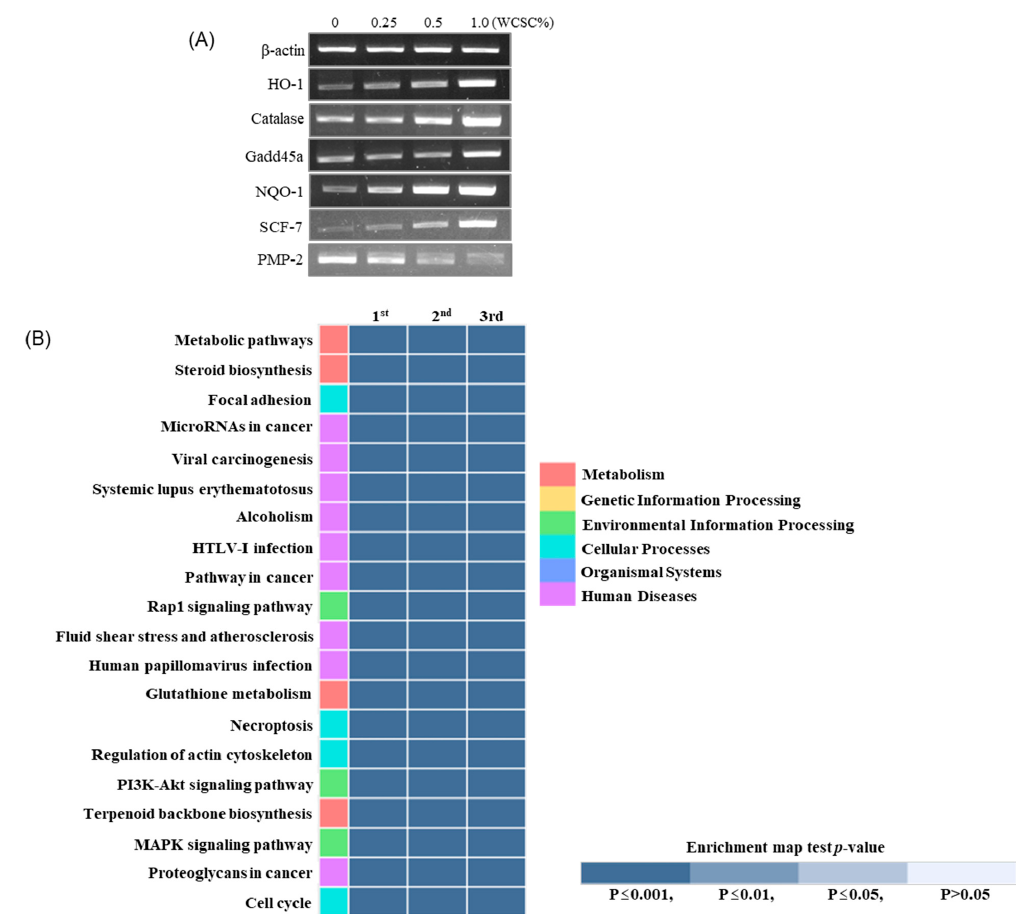
Figure 7. Altered gene expression: ( A ) concentration-dependent changes of individual genes. Experiments were independently performed three times. All the data showed a similar trend, and representative data were proposed; ( B ) KEGG pathway analysis. The heatmap was produced on top 20 terms in an enrichment test with p -value ( p ≤ 0.001).